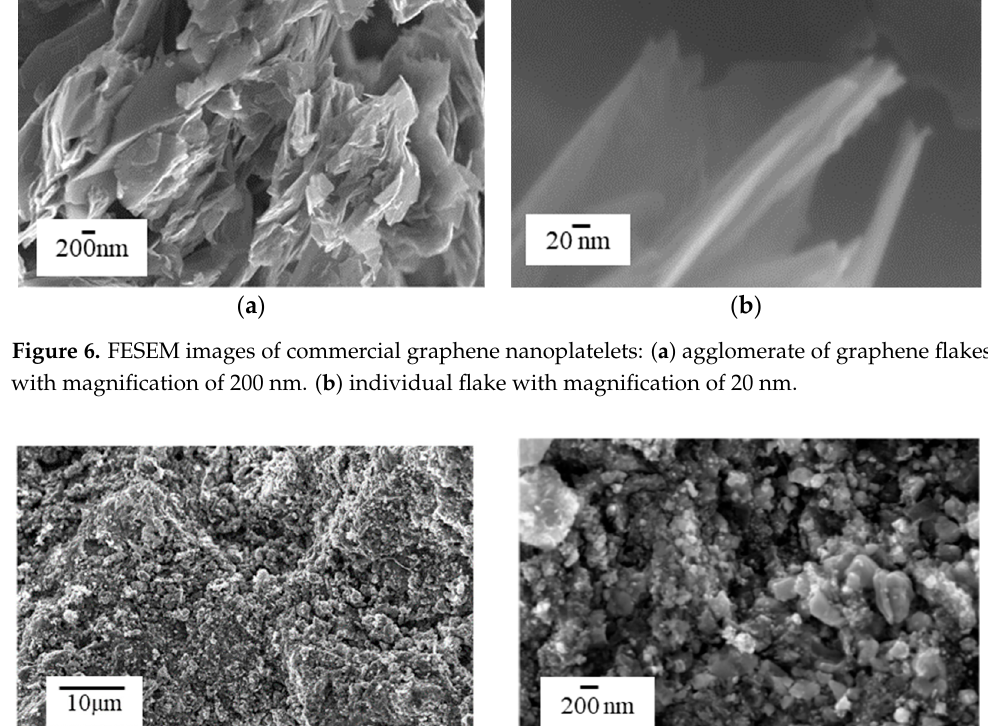
Figure 5. Raman average spectra of the fillers and films: ( a ) graphene filler (solid black line); ( b ) graphene film (dash black line); ( c ) biochar filler (solid red line); ( d ) biochar film (dash red line).